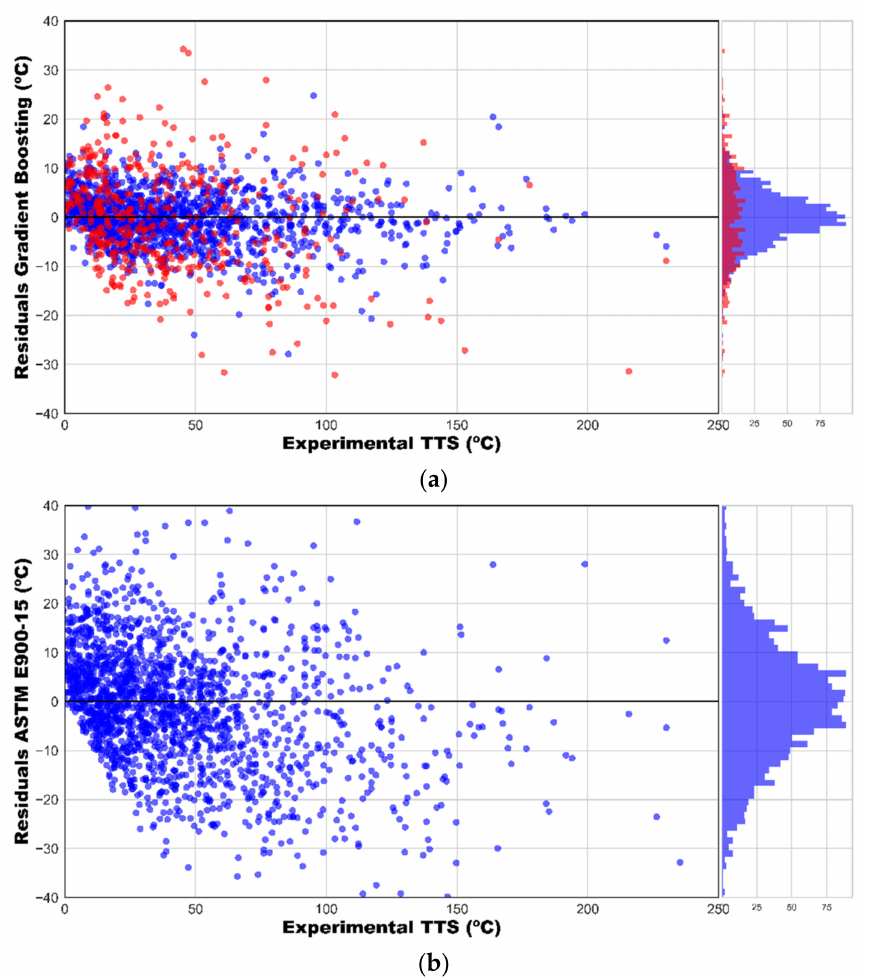
Figure 8. ( a ) Residuals plot obtained through the GB algorithm for the train and test datasets, ( b ) residuals plot provided by the ASTM E900-15